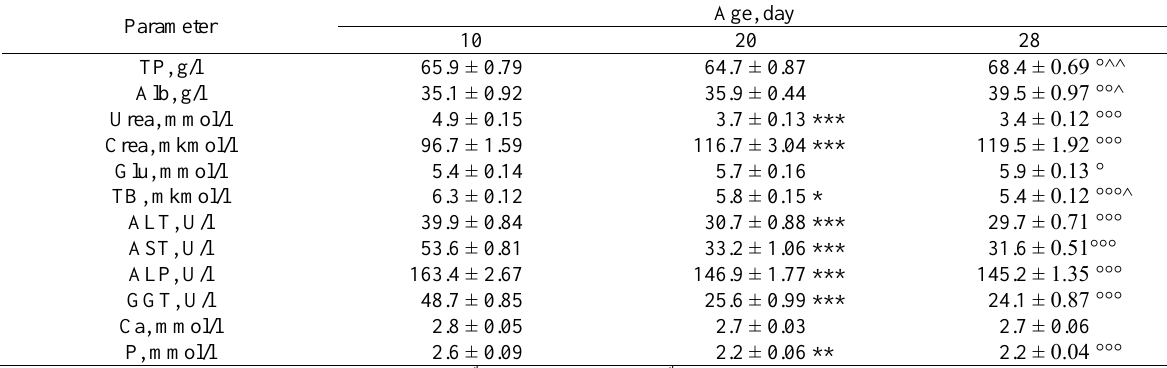
Serum biochemical parameters in experimental group of piglets (M ± m; n = 20)